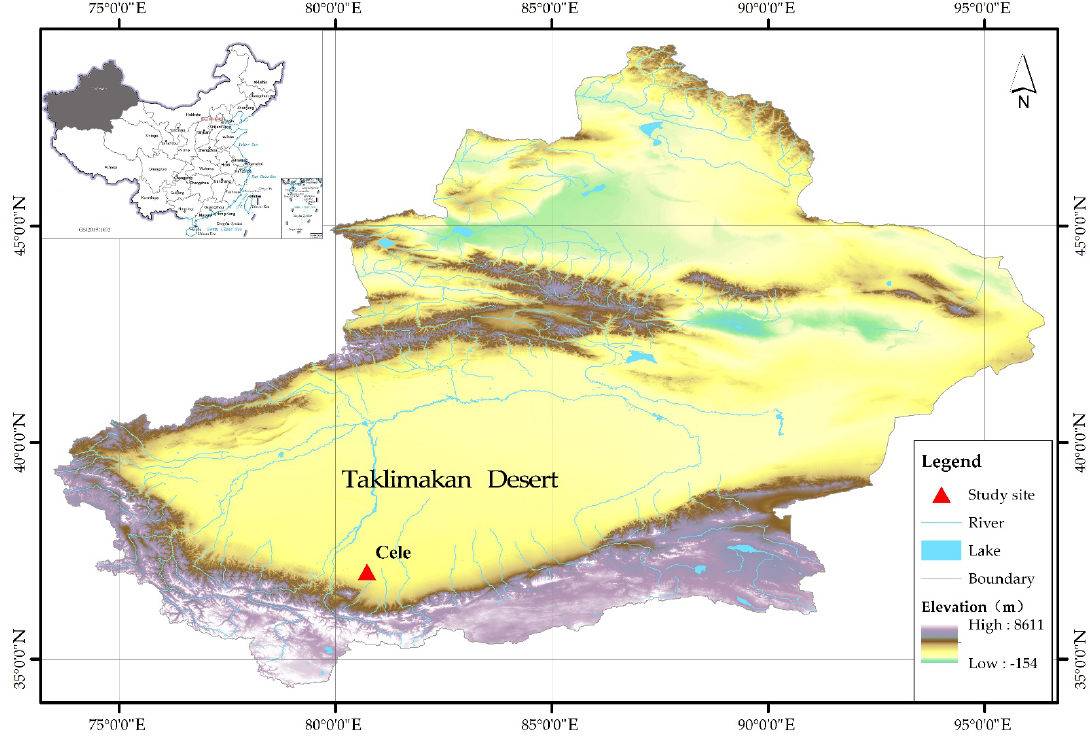
Figure 1. Study site at the southern margin of the Taklimakan Desert in southern Xinjiang, China.